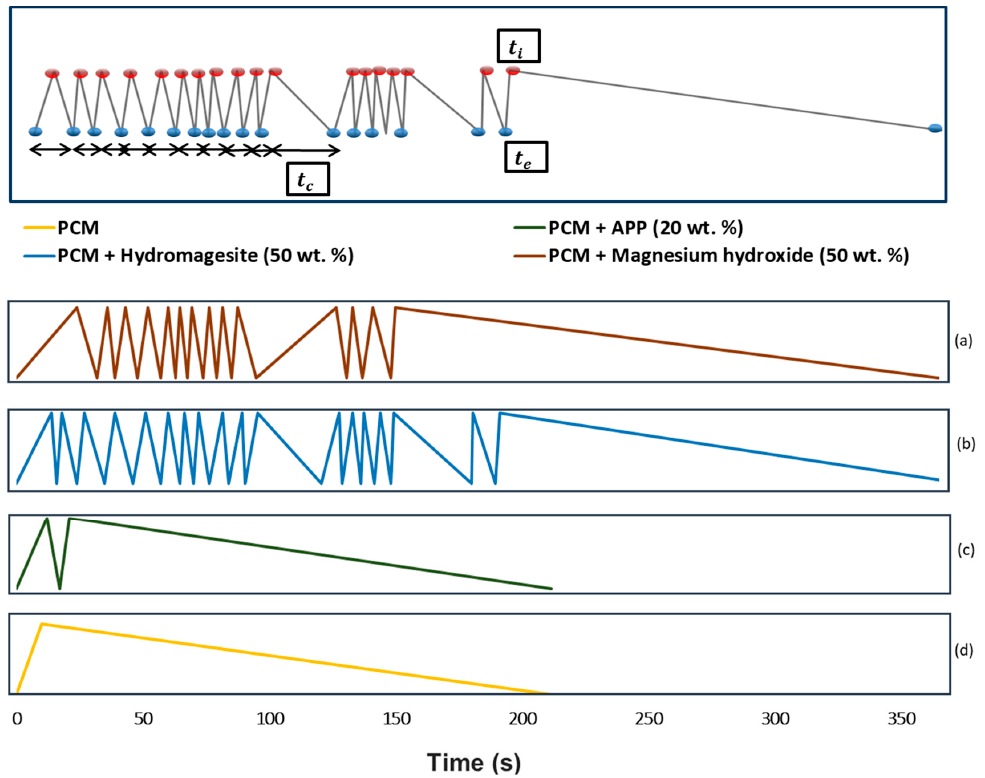
Figure 4. Legend of the parameters to comprehend the graph (above) and ignition-extinction periods for CA + MA mixture formulation with flame retardants (below). ( a ) Fire performance of capric and myristic eutectic with 50 wt % magnesium hydroxide; ( b ) Fire performance of capric and myristic eutectic with 50 wt % hydromagnesite; ( c ) Fire performance of capric and myristic eutectic with 20 wt % APP; ( d ) Fire performance of capric and myristic eutectic mixture. t i : ignition time; t e : extinction time; t c : combustion time. Table 5. DSC of PCM-fire retardant optimum combination